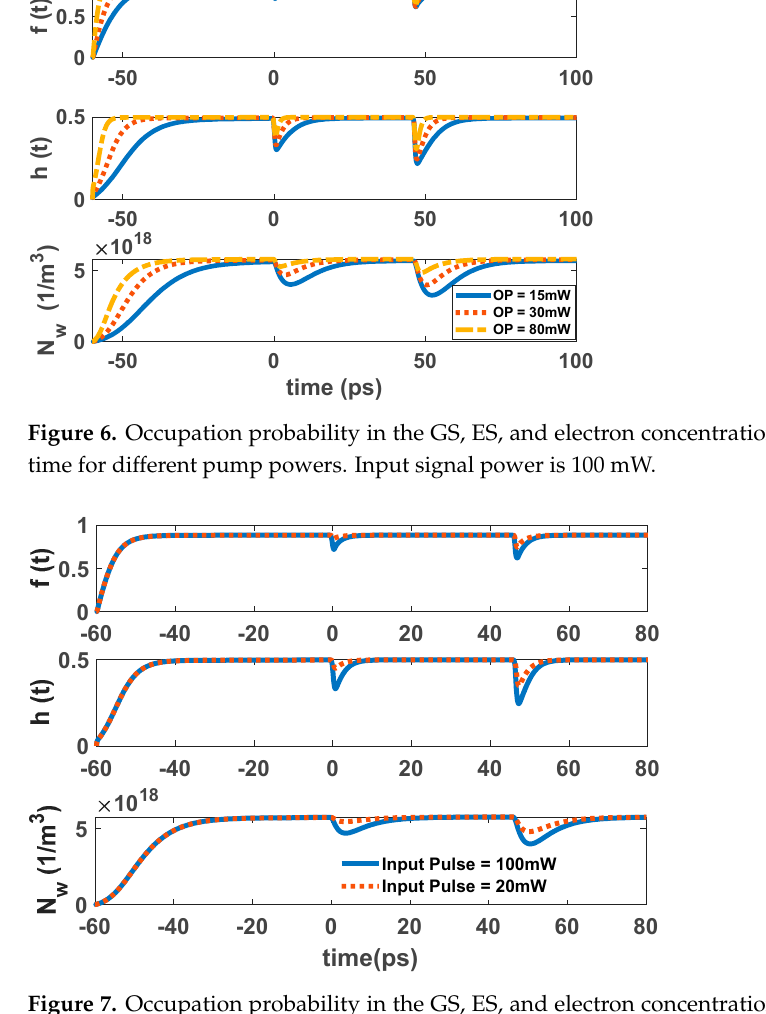
Figure 7. Occupation probability in the GS, ES, and electron concentration in WL as a function of time for different input pulse power. Optical pump power is 30 mW.